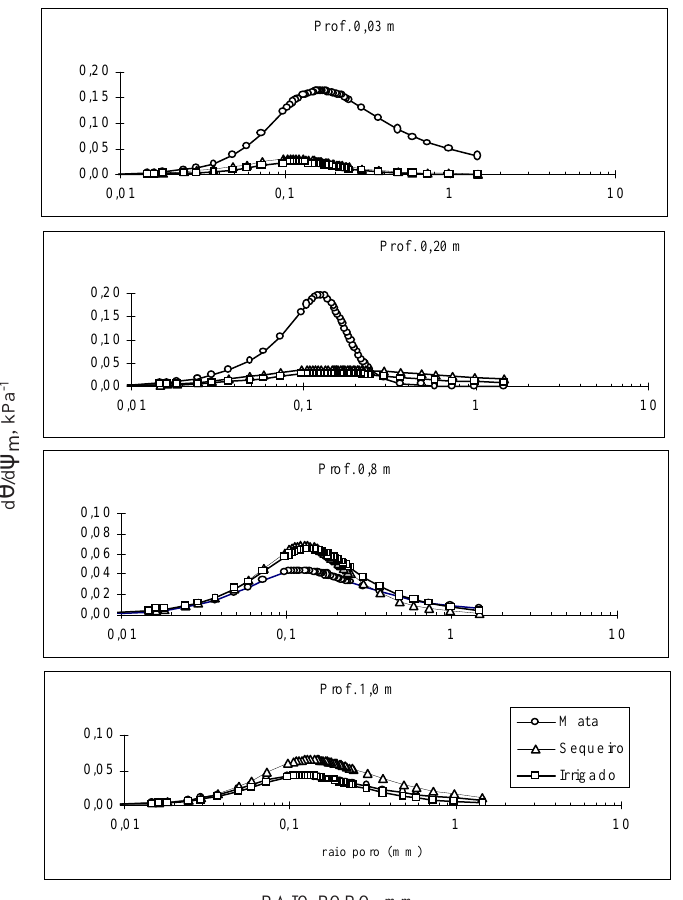
Figura 2. Distribuição do tamanho dos poros do solo, determinados pela derivação da equação de ajuste da curva de retenção em relação ao potencial